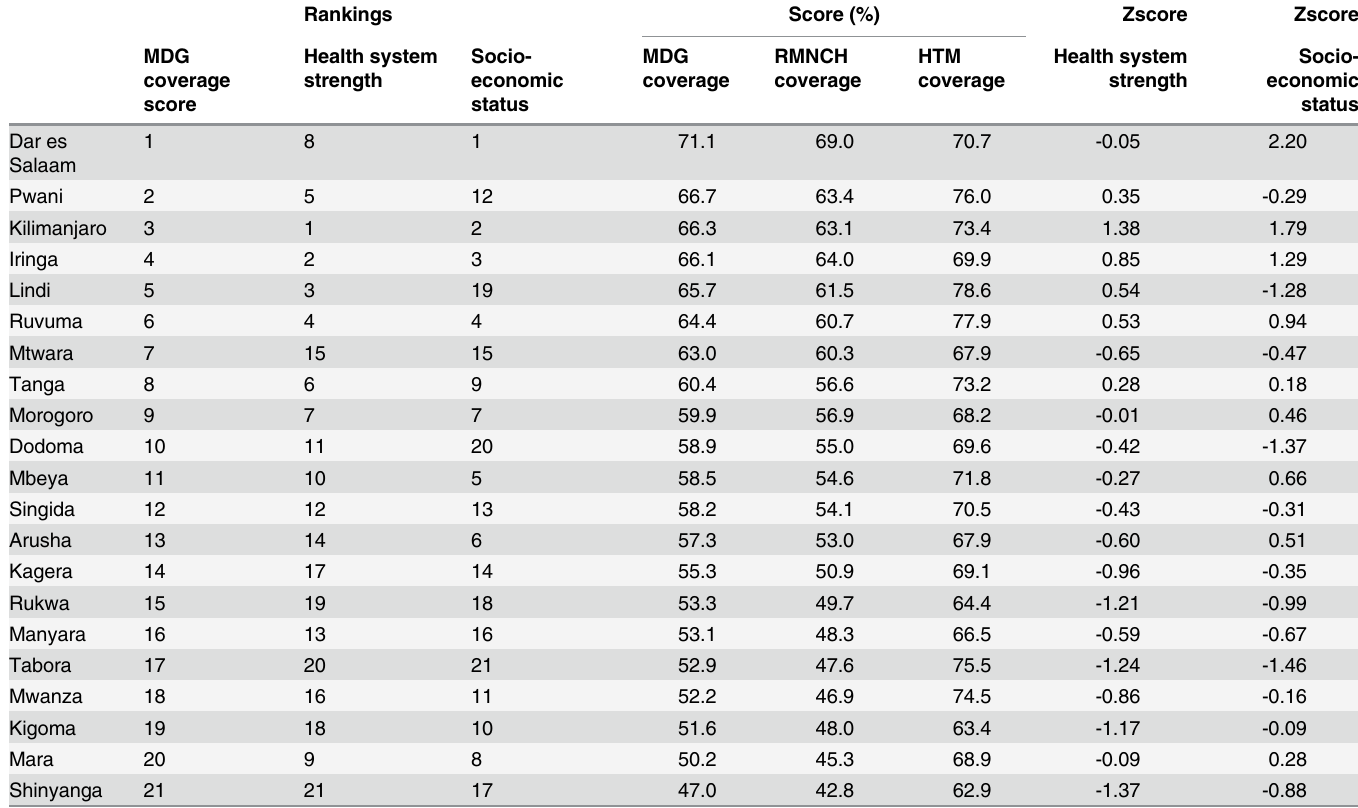
Table 2. Coverage score by region, 2010 – 12: ranking and scores, Tanzania mainland, 2012.